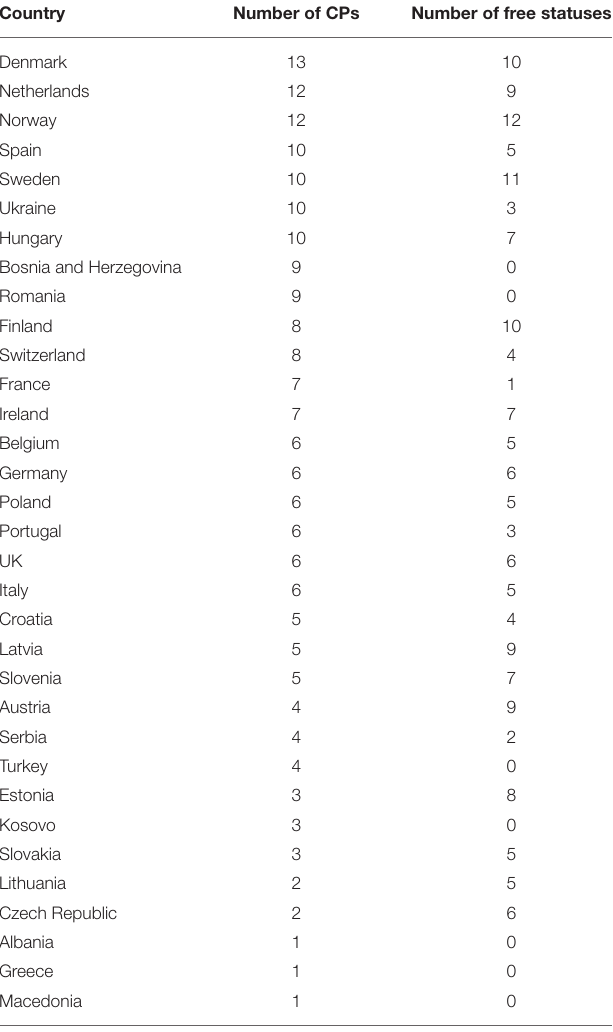
TABLE 2 | Number of control programmes (CPs) and free statuses per country. Country Number of